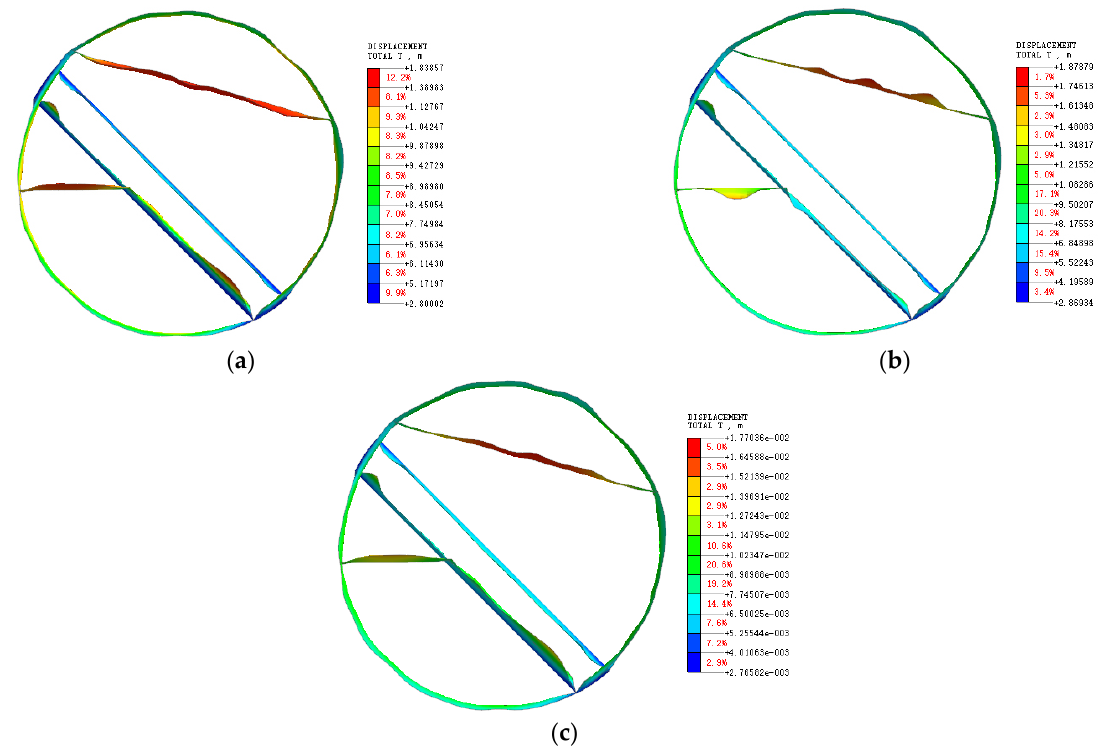
Figure 11. The deformation nephogram of the supporting structure. ( a ) working Condition 1. ( b ) working Condition 2. ( c ) working Condition 3.